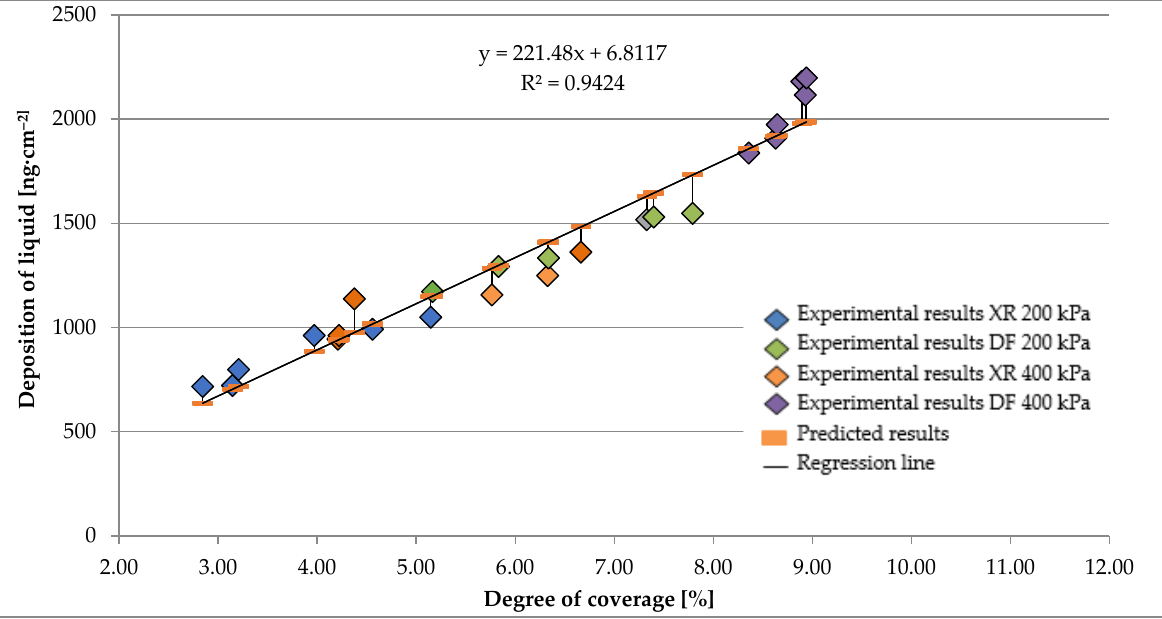
Figure 5. The scatter plot of the degree of coverage and deposition of spray liquid for selected standard nozzles for approach vertical surface.